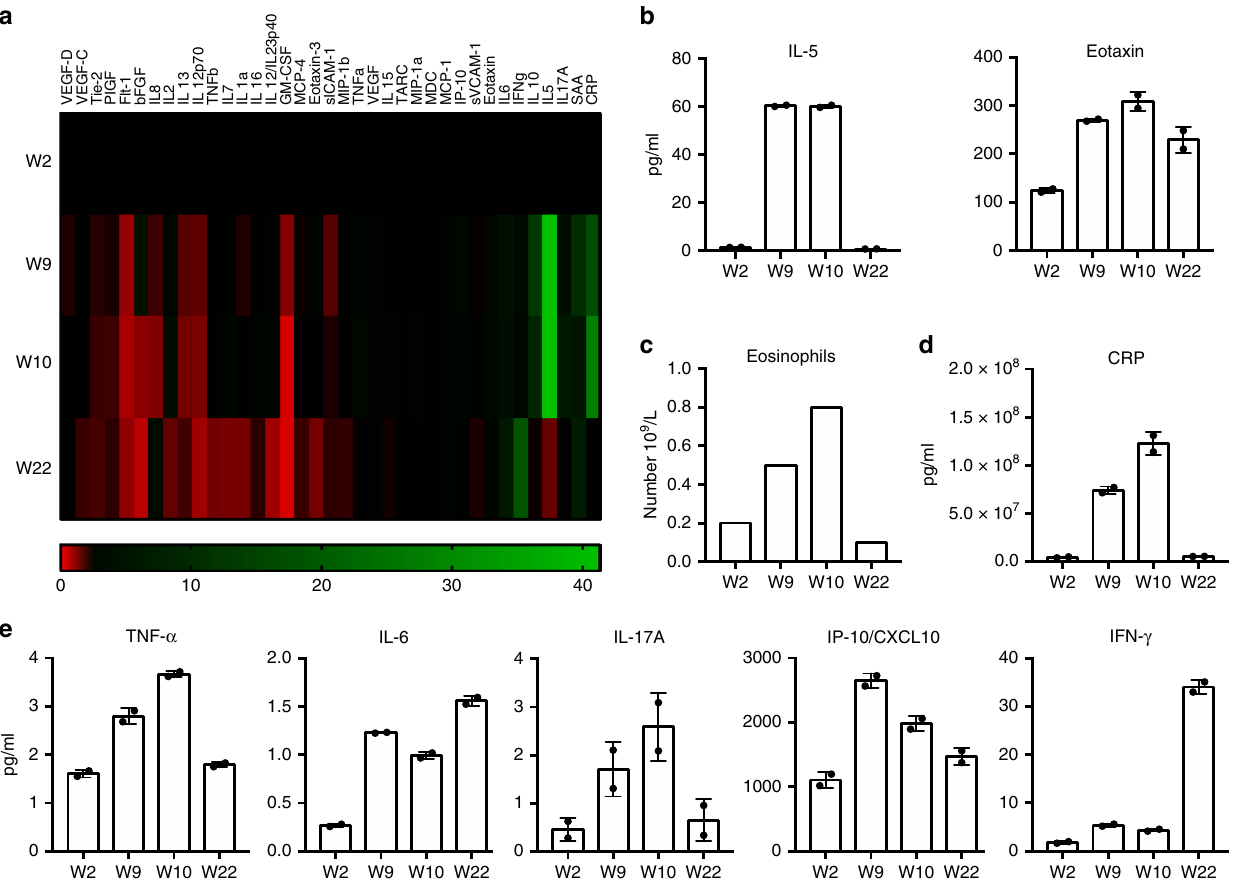
Fig. 2 Analysis of in fl ammatory mediators during ICI-mTORi combination therapy. a Cytokine and chemokine expression levels were determined using a multiplex cytokine assay. Each column represents a speci fi c cytokine or chemokine as indicated at the top of the heat map. The four time points are de fi ned on the left side of the fi gure and the relative levels of each circulating cytokine, compared to baseline, is color-coded according to the gauge at the bottom of the fi gure. Absolute values of b interleukin (IL)-5, eotaxin, d CRP e TNF- α , IL-6, IL-17A, IP-10/CXCL10, and interferon (IFN)- γ are shown at the four treatment time points. All cytokine measurements were completed in duplicates, mean ± SD are shown. c Absolute numbers of eosinophils as were determined by complete blood cell counts from blood taken at the four different time points are